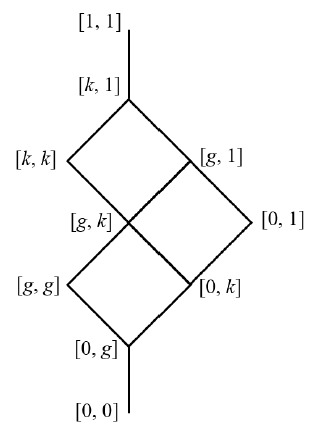
Figure 2. Structure of algebra in Example